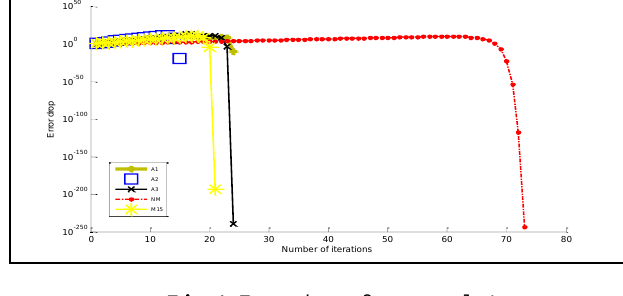
Fig. 4. Error drops for example 1